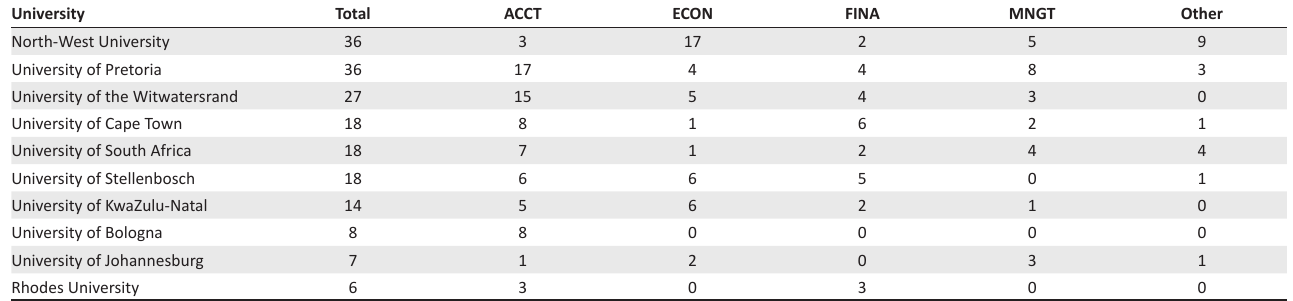
TABLE 9: Top universities (number of articles during 2015–2016).